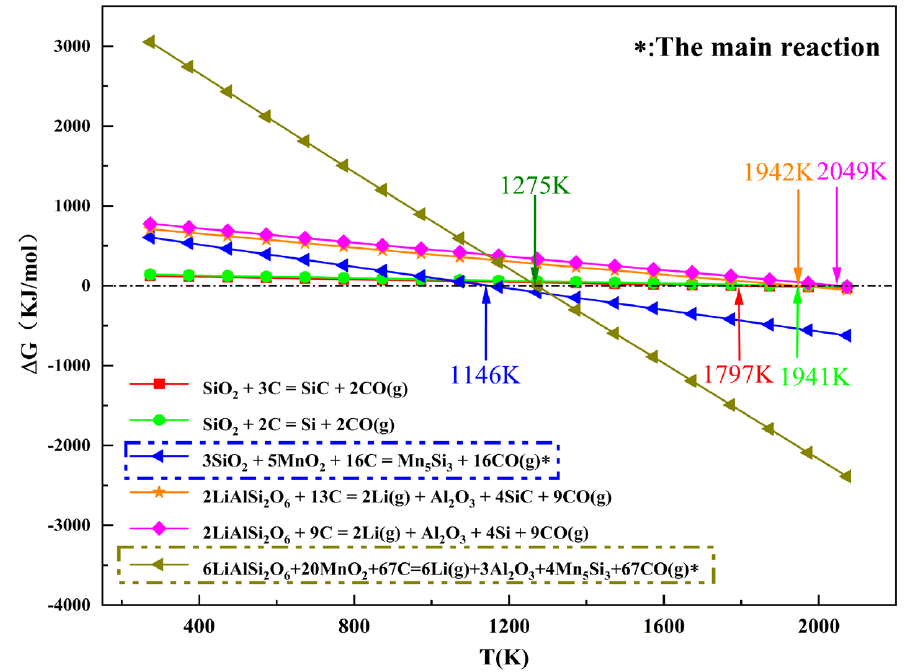
Figure 3. Thermodynamic calculations of possible reactions.